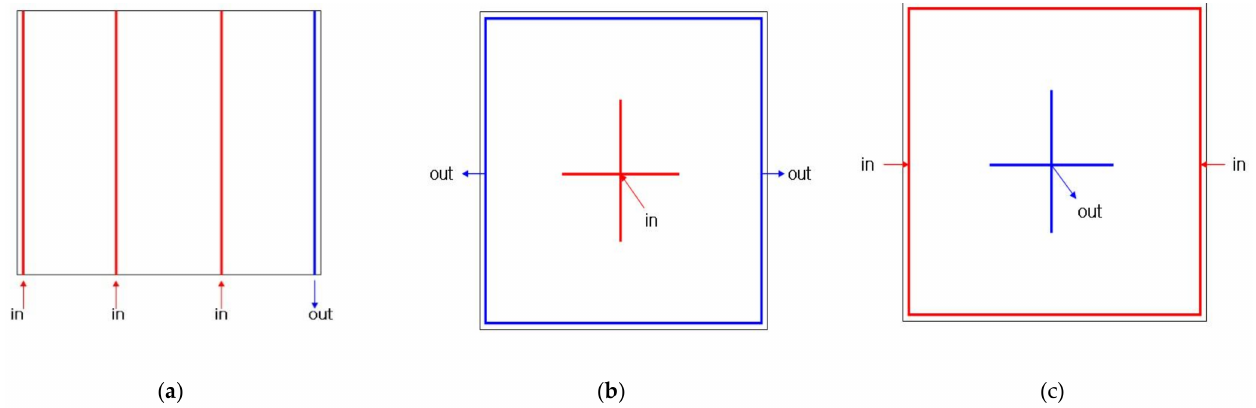
Figure 8. The resin infusion strategy of plates: ( a ) Injection from three parts and exhaust from one part, ( b ) Inject from the center and exhaust from the side, ( c ) Injection from the side and exhaust from the center.